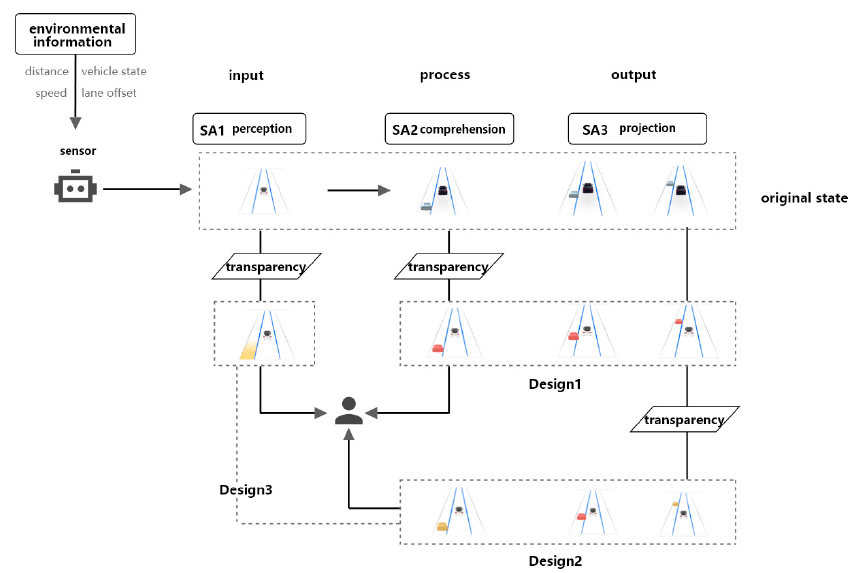
Figure 4. The analysis process of the three designs. Design1 enhances the original interface with the SA2 stage’s transparency design, Design2 enhances Design1 with the SA3 stage’s transpar- ency design, and Design3 enhances Design2 with the SA1 stage’s transparency